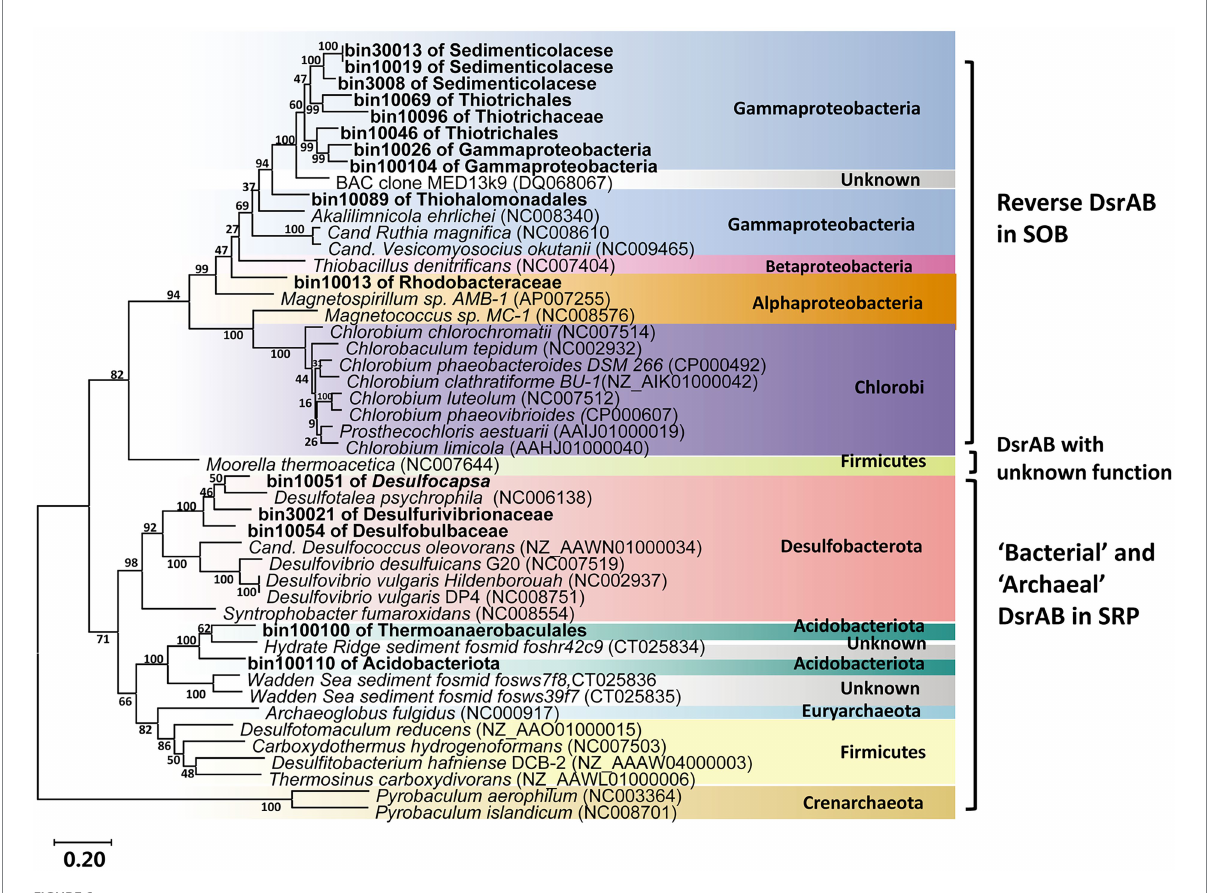
FIGURE 6 Phylogenetic tree of dsrAB amino acid sequences from all related MAGs. The reference gene was from Loy et al. (2009). Scale bar indicates 20% sequences divergence as estimated from distance-matrix analysis. The labelled names of MAGs were the lowest taxonomic level assigned by GTDB (Supplementary Table